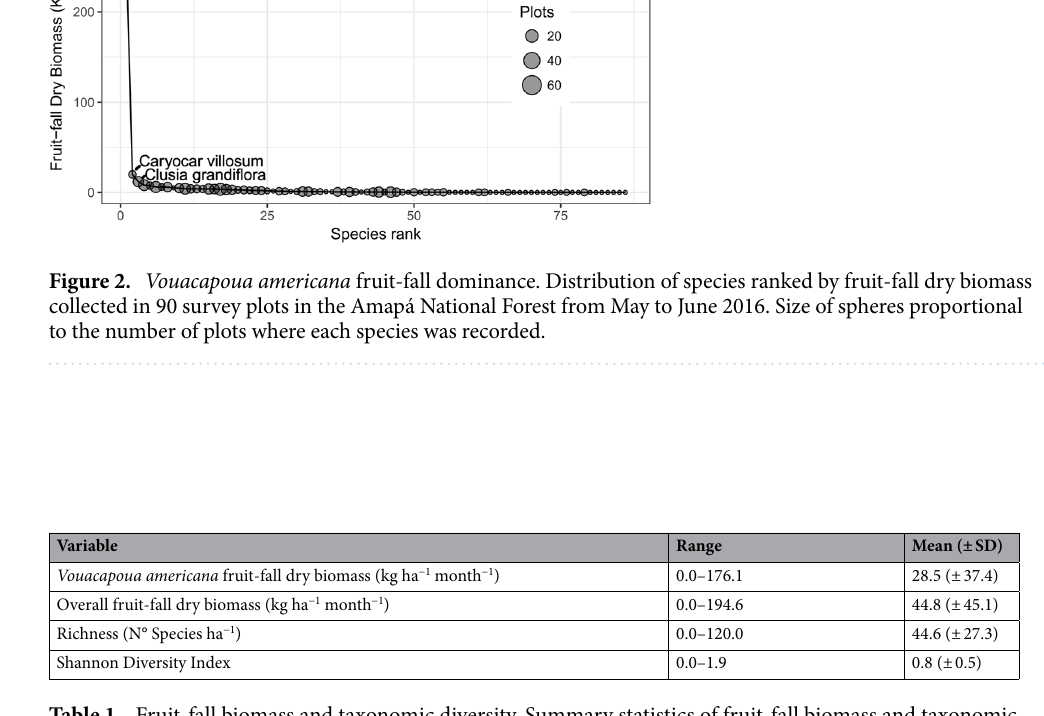
Table 1. Fruit-fall biomass and taxonomic diversity. Summary statistics of fruit-fall biomass and taxonomic diversity recorded in 90 survey plots in the Amapá National